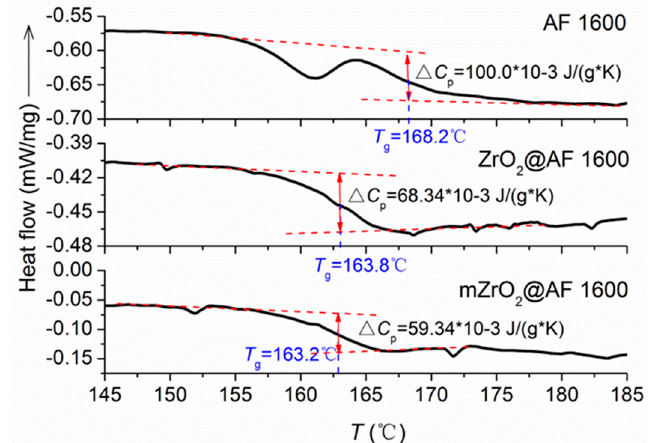
Figure 2. FT-IR spectra of crude zirconia (ZrO 2 ) and surface fluoro-modified zirconia (mZrO 2 ). The related peaks listed below: 1240–1100 cm –1 ( ν s, C–F on PFAS) and 1070 cm –1 ( ν as, Si–O linked with ZrO 2 ).